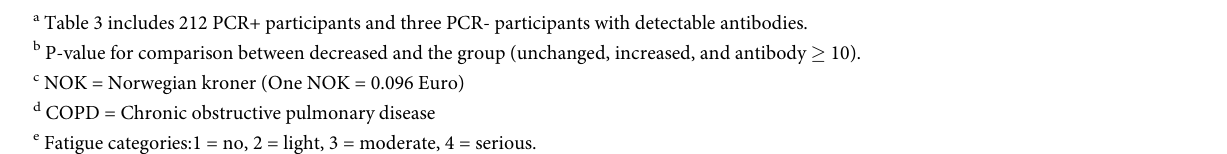
Table 4. Possible predictors for decreased antibodies after 10 to 12 months compared with increased, unchanged and antibody � 10 using univariate analysis adjusted for age and sex, and multivariate analysis adjusted for all variables.